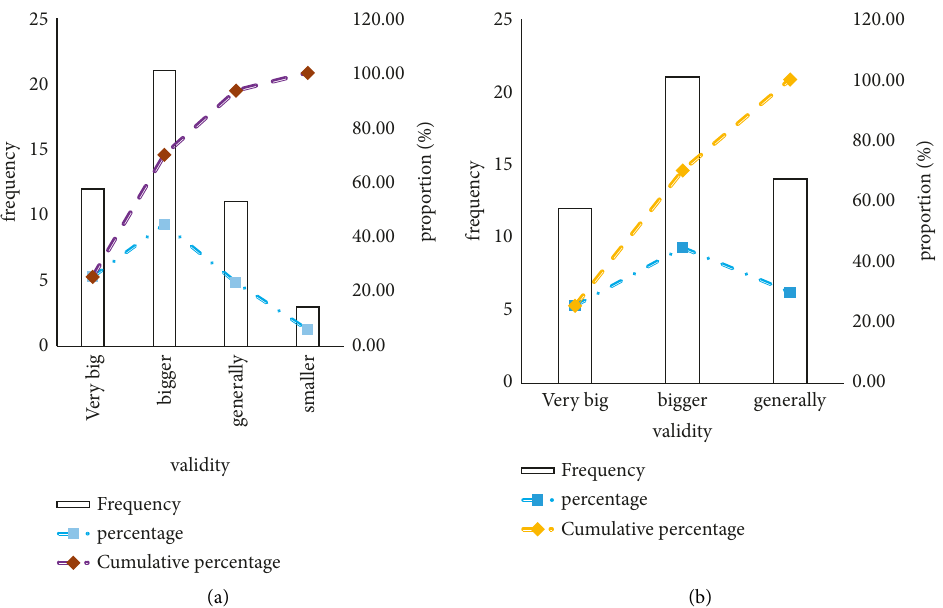
Figure 10: The effect of martial arts education on developing self-awareness and developing independence: (a) effect on developing self- awareness and (b) effect on developing independence. Table 1: Analysis of martial arts learning situation of students in the first two classes of the experiment. Survey dimensions Experimental class Control